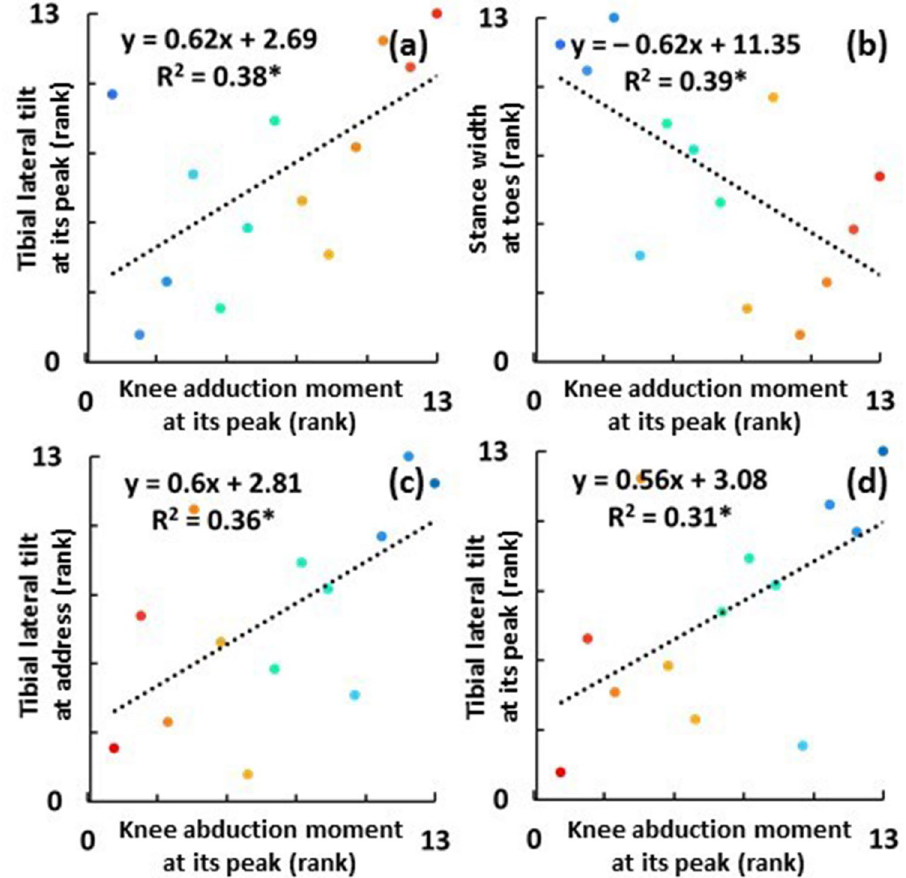
Figure 3. Spearman correlations between the peak knee adduction moment of the lead leg and ( a ) lead tibial lateral tilt at its peak and ( b ) stance width at address using toe markers and between the peak knee abduction moment of the lead leg and ( c ) lead tibial lateral tilt at address and ( d ) at its peak. Each dot represents the rank over mean value of each participant over 5 shots. The rank of the peak knee adduction moment is expressed in ascending order (1: low, 13: high), while that of the abduction is descending (1: high, 13: low) due to negative denotation. The gradation of colors in warm and cool represent the high and low knee add/abduction moments at its peaks, respectively. *significant at p <